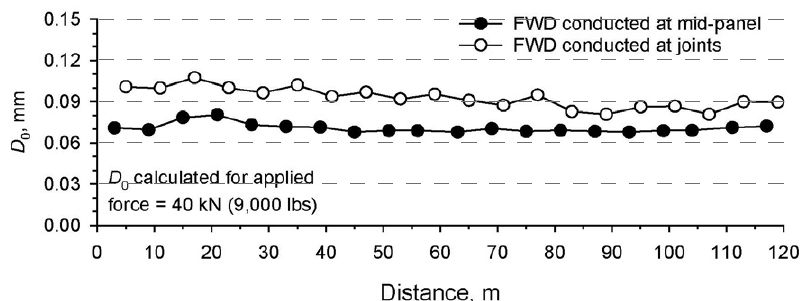
D 0 The varied slightly but presented significant differences between the measurements at mid-panel and joints. It ranged from 0.07 to 0.08 mm at mid-panel and 0.09 mm to 0.11 mm at joints. By the DCP results (refer to Figure 4), several of the test locations with lower displayed relatively higher deflections. Deflection data from other FWD k sensors were used along with the corresponding calculate the